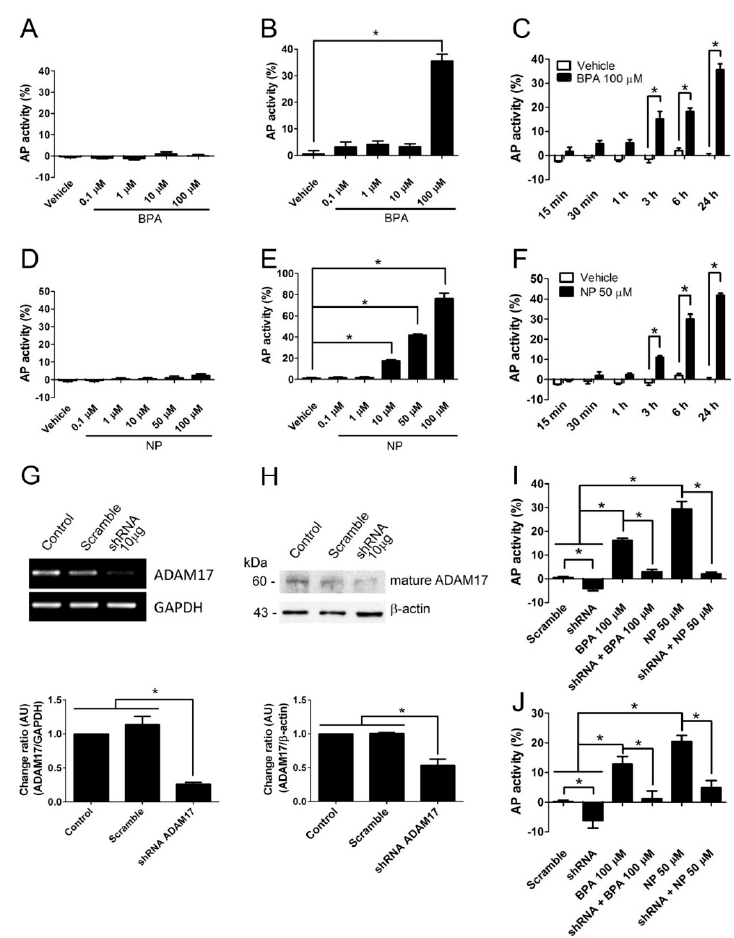
Figure 1. A Disintegrin And Metalloprotease 17 (ADAM17) sheddase activity is induced by bisphenol A (BPA) and nonylphenol (NP) in LNCaP cells transfected with alkaline phosphatase (AP)-neuregulin 1 (NGR1) vector. LNCaP cells show no detectable AP activity in culture medium when incubated with BPA ( A ) or NP ( D ) when they are not transfected with (AP)-NRG1 vector. LNCaP cells transfected with (AP)-NGR1 vector show a significant increase in culture medium when they are incubated for 24 h in the presence of 100 µ M BPA ( B ) or 10–100 µ M NP ( E ). Time course of AP activity release of transfected LNCaP cells with (AP)-NRG1 vector using 100 µ M BPA ( C ) or 50 µ M NP ( F ). Transfection of LNCaP cells with 10 µ g shRNA induces a robust decrease in the levels of mRNA ( G ) and protein ( H ) of ADAM17. Silencing of ADAM17 with 10 µ g shRNA in transfected LNCaP cells with